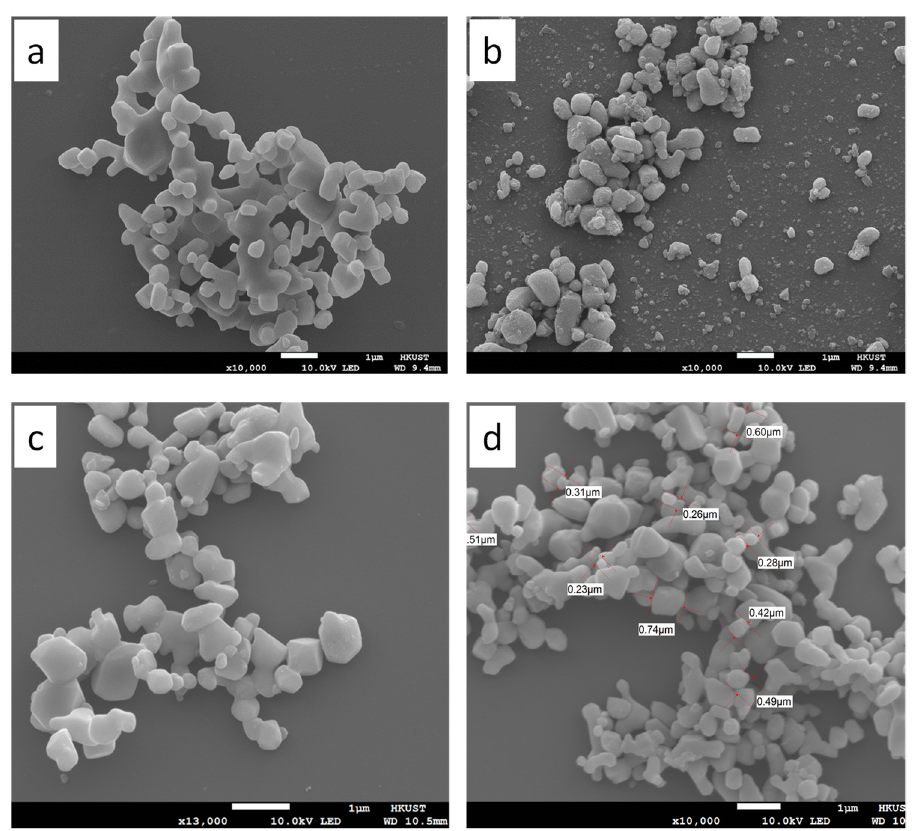
Figure 5. SEM images of ( a ) pristine TiO 2 , ( b ) Fe/TiO 2 –34, ( c ) Fe/TiO 2 –17, and ( d ) Fe/TiO 2 ⁻ 7.